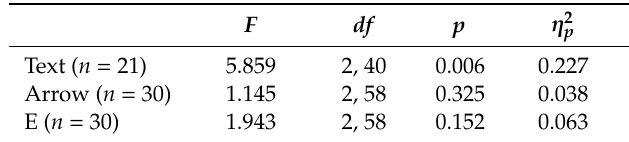
Table 9. Statistics for the ANOVAs conducted to evaluate the e ff ect of content color with respect to content type.